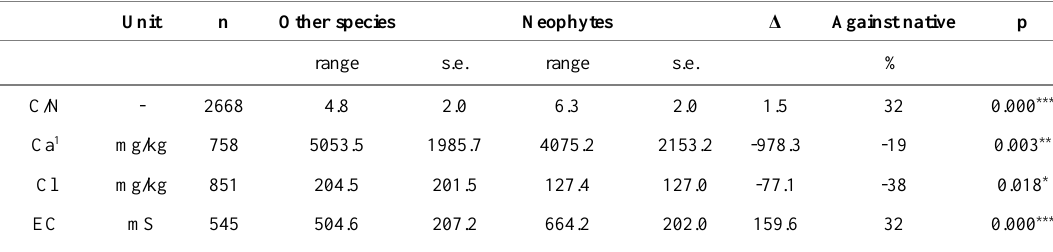
Table 1. Species ranges for abiotic soil parameters for neophytes and other Dutch plant species, including standard error, the difference between both groups and the p-values for the difference (two tail student t-test, n.s.; not significant, * p<0.05, ** p<0.01, *** p<0.001). Results per species are given in Appendix 1 for neophytes and Appendix 2 for the ‘other species’. N gives the number of entries of the parameter in the EC-database, i.e. the number of field measurements. With EC: Electric Conductivity; MSL: mean spring groundwater level; MHL: mean highest groundwater level; MLL: mean lowest groundwater level (the latter three in cm below surface) and moisture: moisture